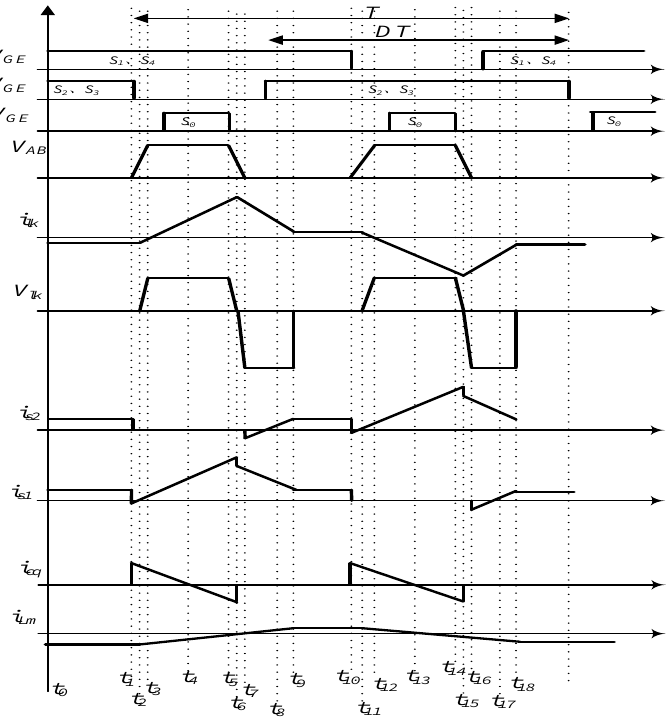
Figure 5. Timing sequence of the converter with soft switching control.